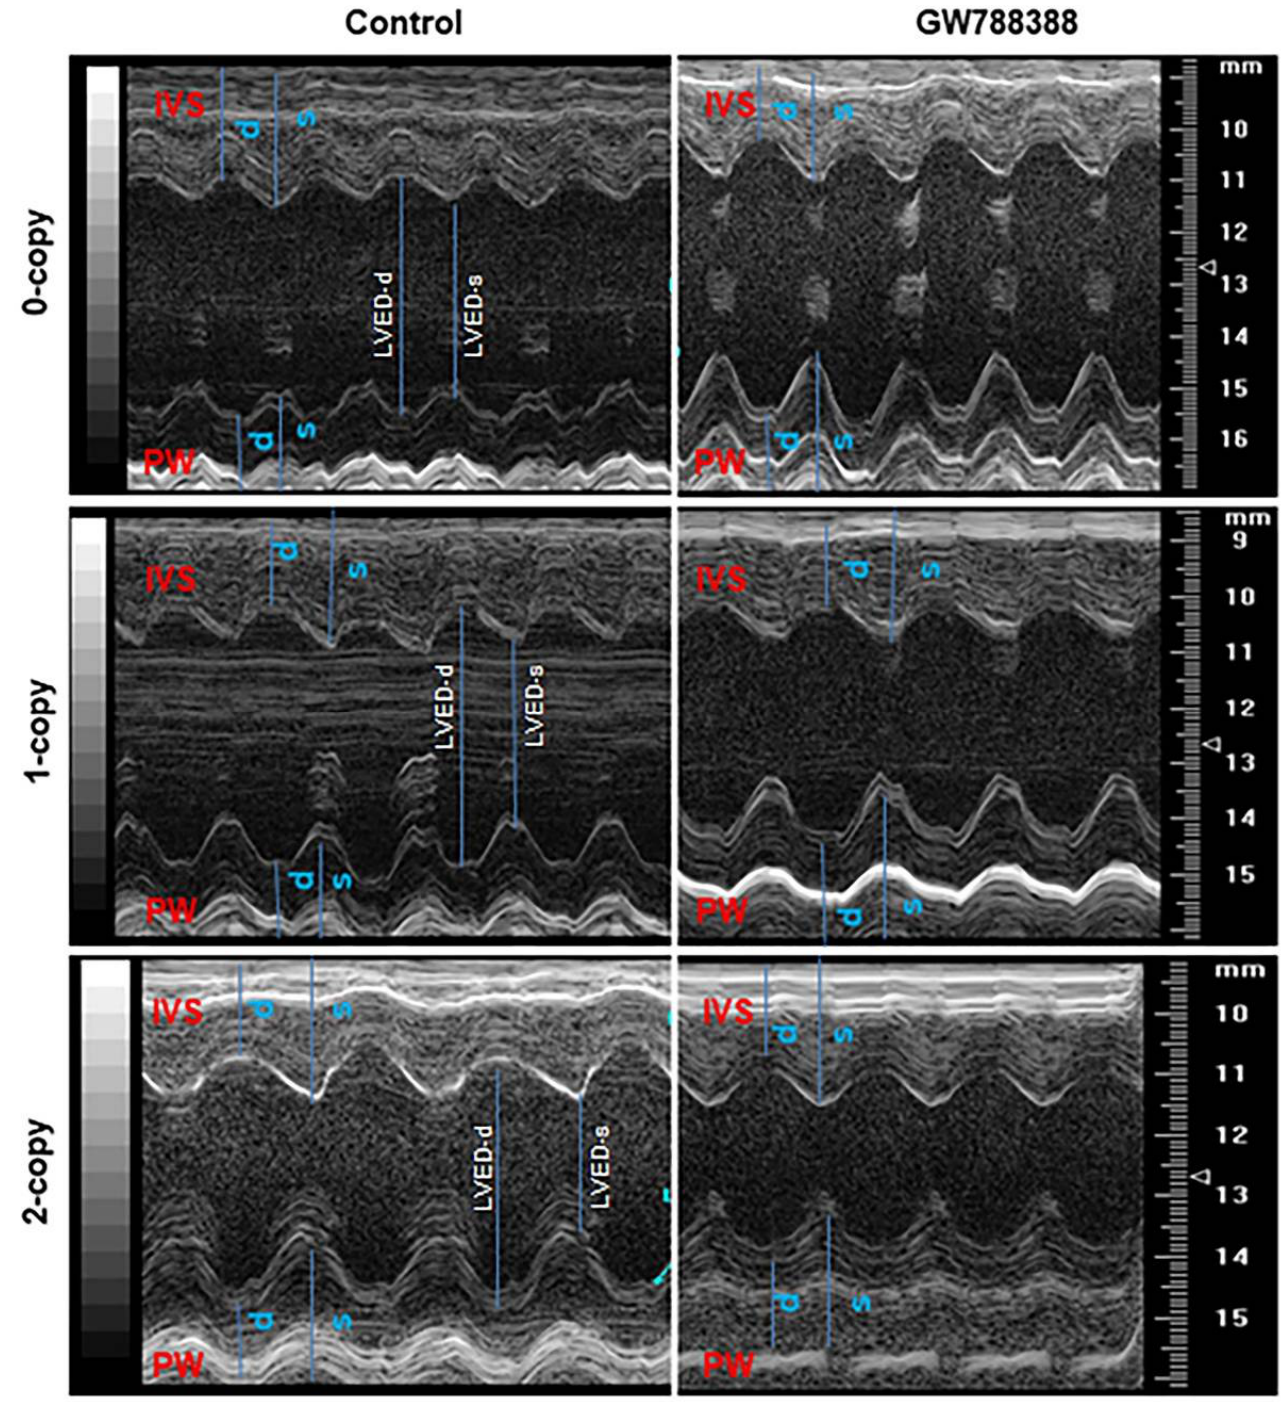
Figure 8. Representative images of the echocardiogram in the left ventricle of control and GW788388 drug-treated male Npr1 gene-disrupted mice: representative M-mode images of the left ventricle for each group were calculated from the average of 6 sessions/day for five consecutive days. The representative images are shown for 0-copy, 1-copy, and 2-copy mice with and without GW788388 treatments. Longer blue lines indicate LVED-d and shorter blue lines indicate LVED-s in the echocardiogram images. Each image is the representative of a minimum of three cardiac cycles per animal (n = 6 mice per groups).